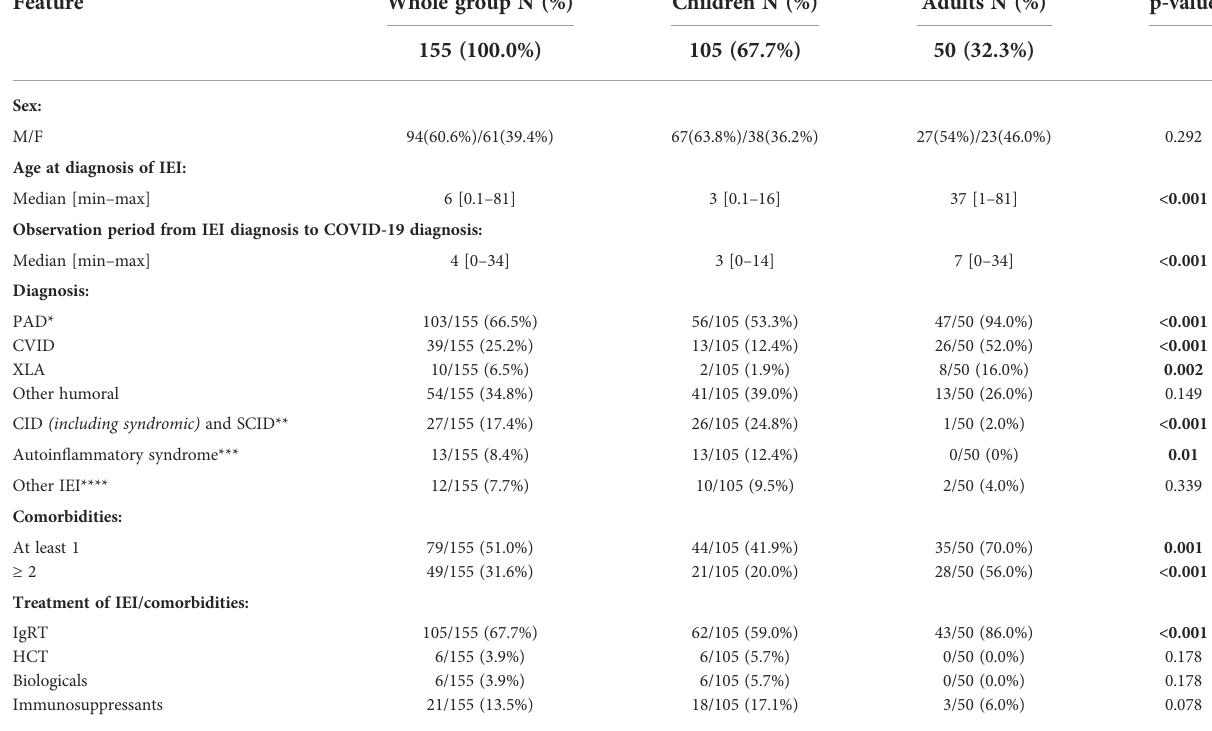
TABLE 1 Characteristics of the study